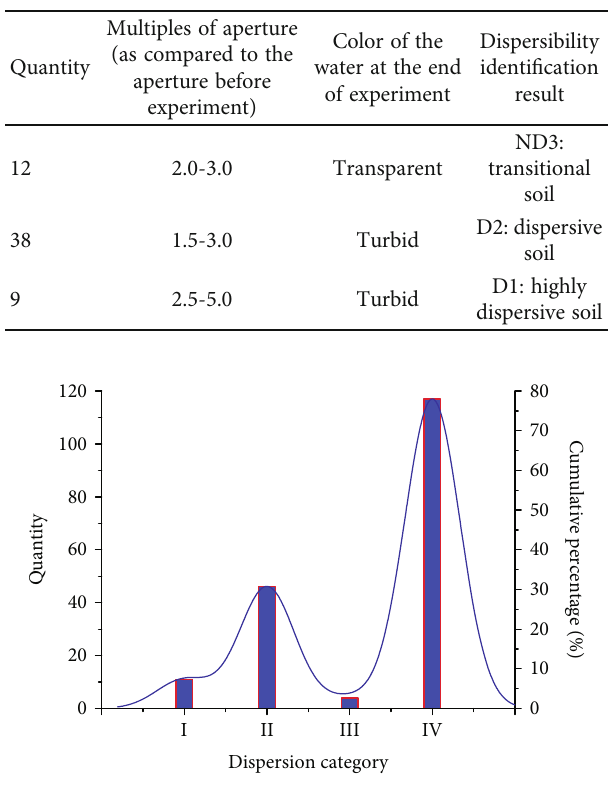
Figure 10: Statistical results of the fragmentation